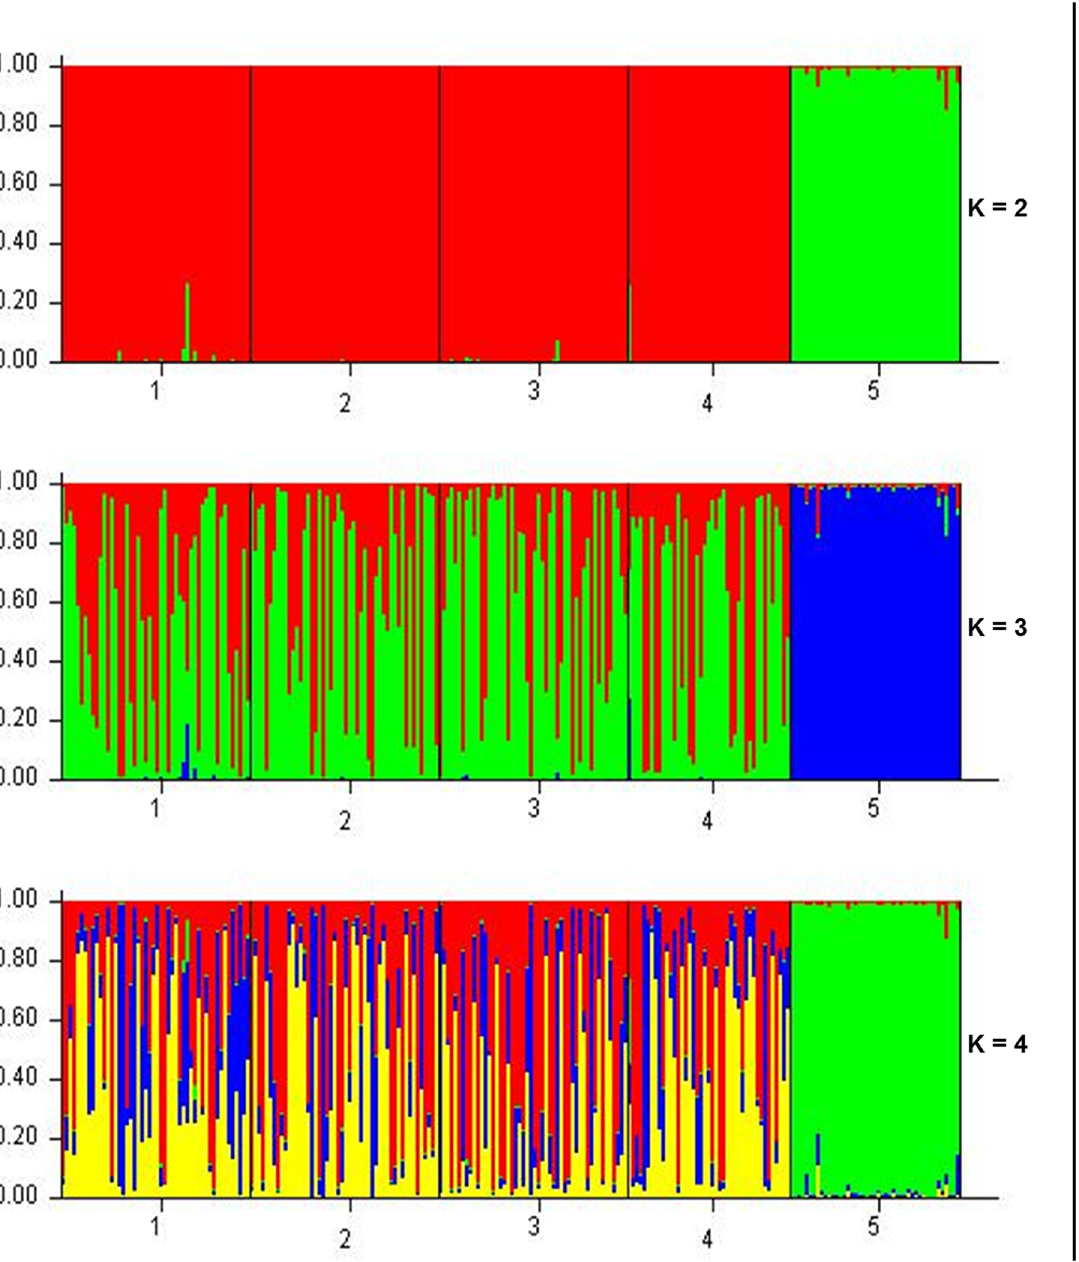
Fig 3. Bar plots of different assumptions of clusters, K in T . albacares based on multilocus data. Plots for values of K = 1 to K = 10 were constructed in STRUCTURE 2.2, with 10 replicate runs for each K value. Plots for the most significant K values, K = 2 to K = 4, are shown.